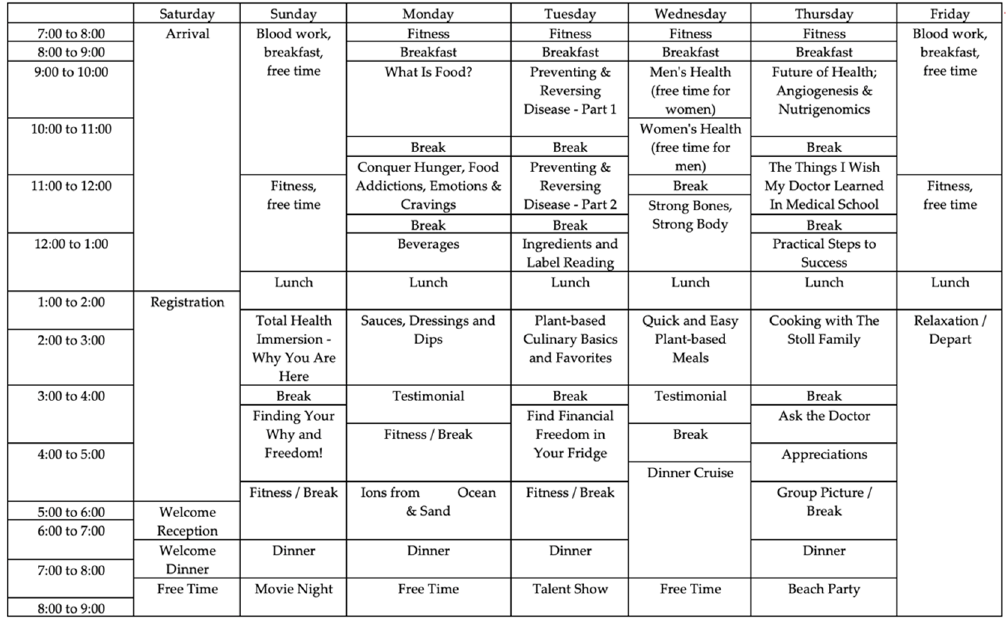
Figure 1. Schedule of the six-day intervention.